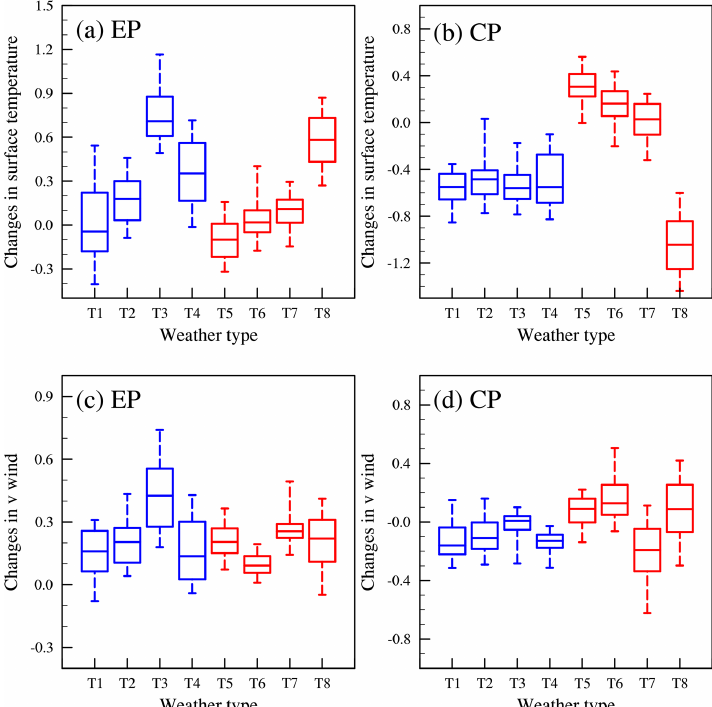
Figure 7. Box-and-whisker plots of anomalies of (a, b) temperature at 2m (unit: K) and (c, d) meridional wind at 10m (unit: ms − 1 ) over the JJJ region under eight circulation types for different types of El Niño years. The blue and red lines represent the clean and pollution circulation types, respectively. Each box and whisker consists of the 5th percentile (the lower point of the whisker), 25th quantile (the lower border of the box), median (horizontal line in the middle of the box), 75th quantile (the upper border of the box), and 95th percentile (the upper point of the